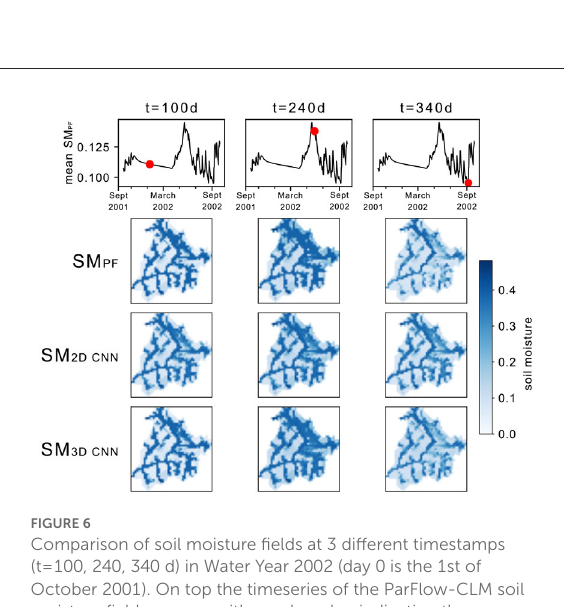
FIGURE6 Comparison of soil moisture fields at 3 different timestamps (t=100, 240, 340 d) in Water Year 2002 (day 0 is the 1st of October 2001). On top the timeseries of the ParFlow-CLM soil moisture field average, with a red marker indicating the timestamp, then the fields simulated by ParFlow-CLM, those produced by the 2D trained CNN model, and at the bottom those produced by the 3D trained CNN